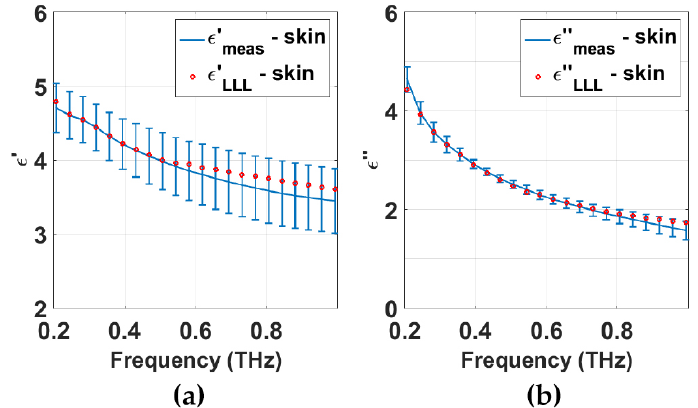
Figure 3. ( a ) Real part and ( b ) imaginary part of porcine skin permittivity. Reprinted with permission from ref. [47] Copyright 2017 Physics in Medicine and Biology.